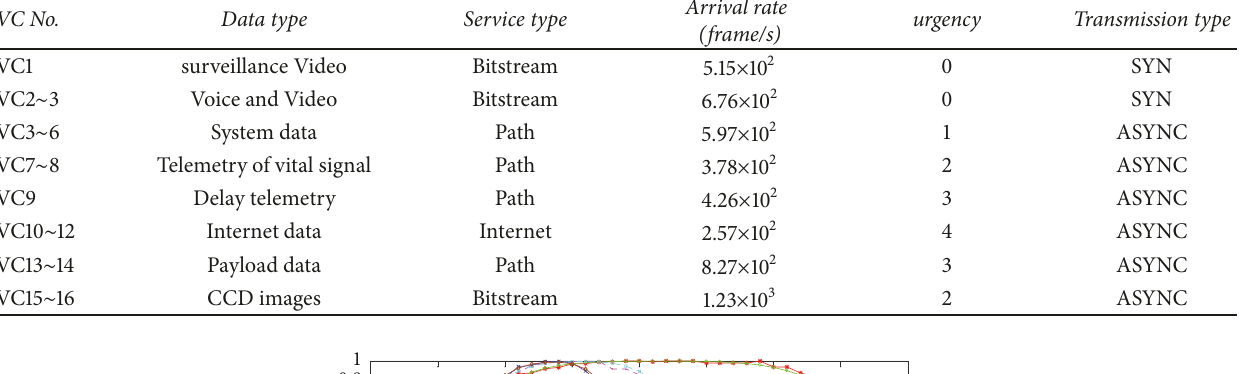
Table 2: Simulation Parameters Table of AOS Virtual Channel.